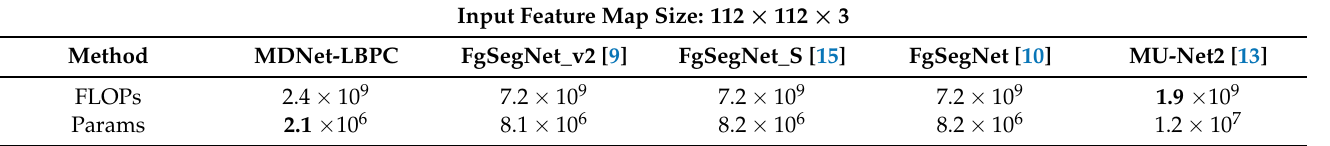
Table 3. Computational comparison with state-of-the-art methods. The best scores are marked in